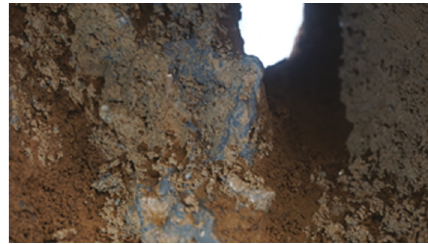
Figure 10: Cement-sodium silicate slurry diffusion. Figure 9: Cement slurry